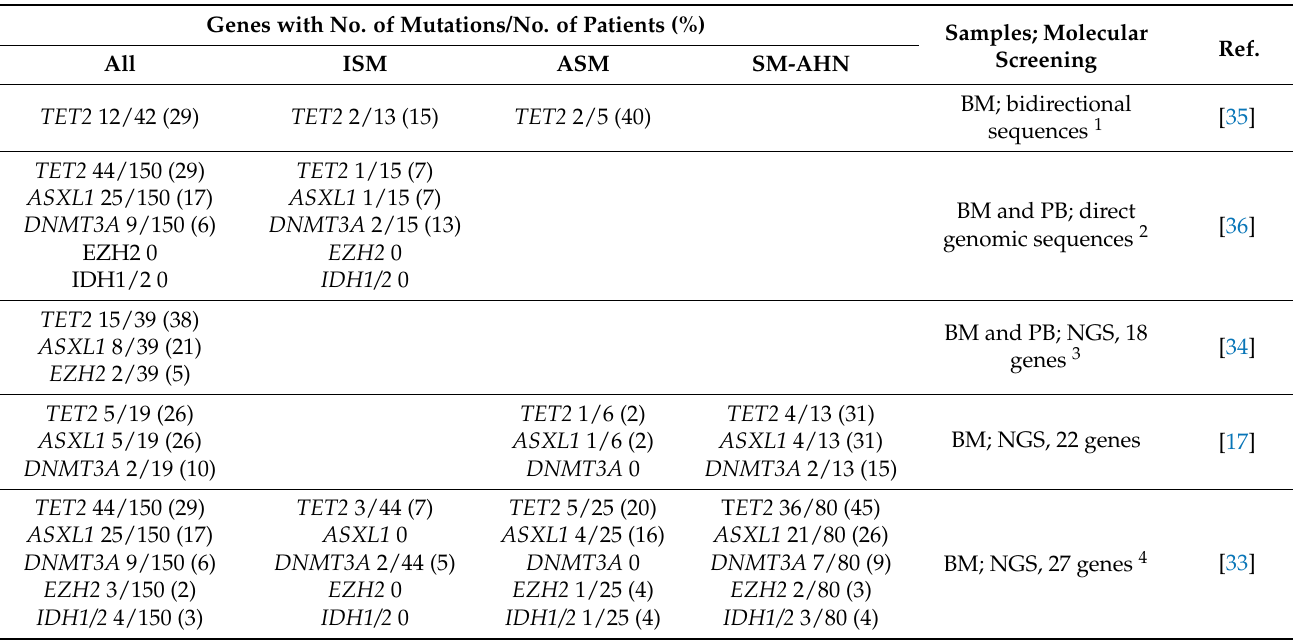
Table 2. non- KIT and epigenetic mutations in different variants of mastocytosis. Genes with No. of Mutations/No. of Patients (%) Samples; Molecular